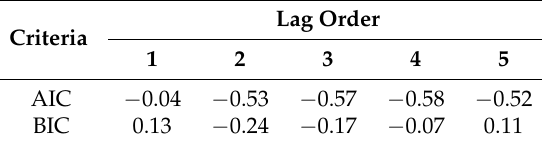
Table 3. Lag order selection for VAR